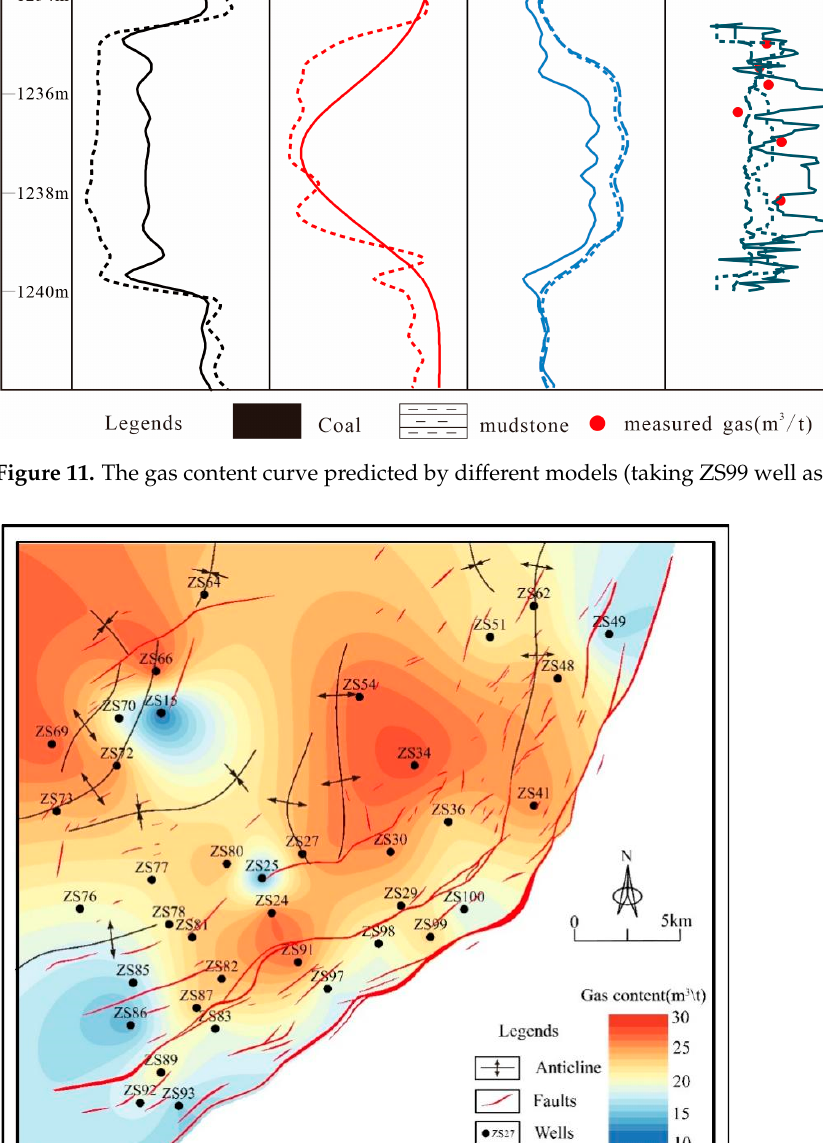
Figure 13. Gas content distribution predicted by different models ( a RF model; b BO-RF model; c GBDT model; d BO-GBDT model). 5. Conclusions